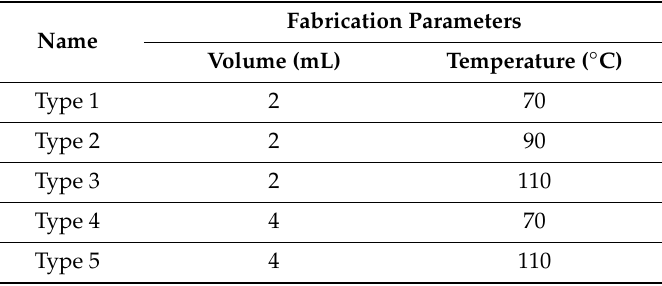
Table 1. Conditions during fabrication for each of the deposited K-Pery layers.